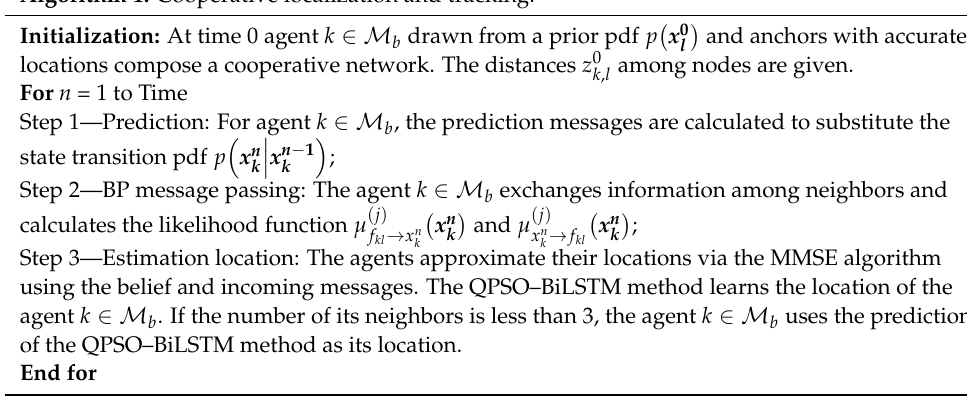
Algorithm 1. Cooperative localization and